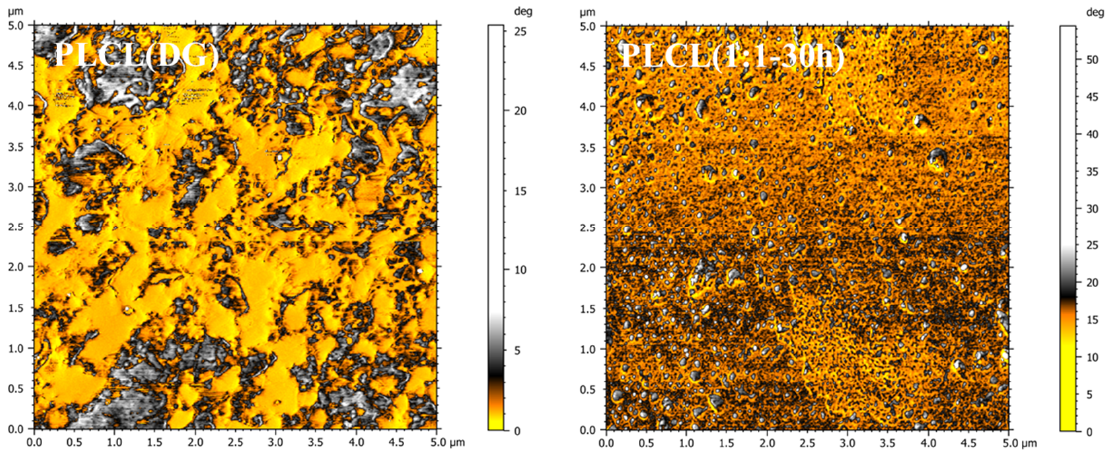
Figure 10. Phase images of PLCL (DG) and PLCL (1:1 - 30 h) across an area of 5 µm × 5 µm.